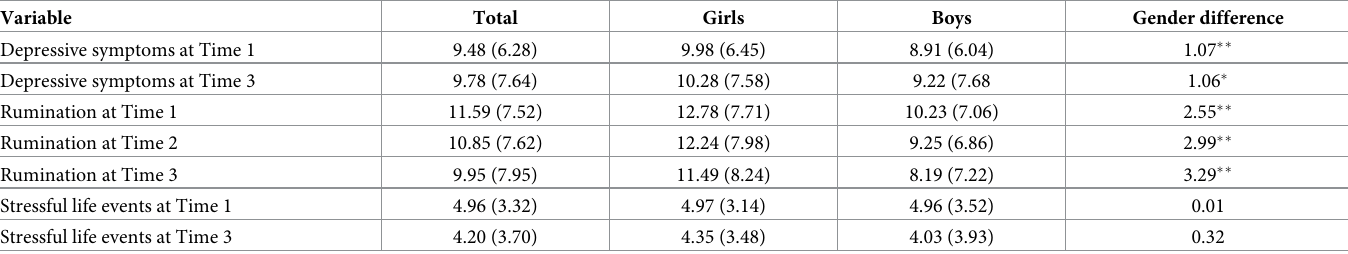
Table 2. Summary of